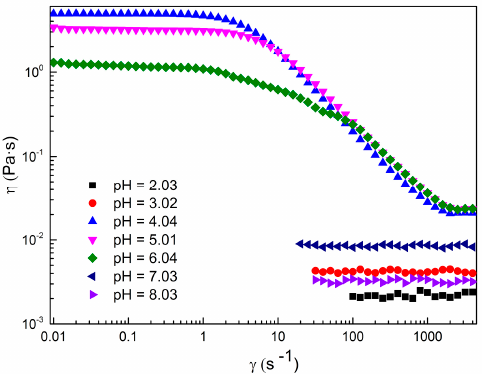
Figure 1. Steady shear viscosity versus shear rate γ (with a dot over the symbol) plots for 80 mM C 16 MPBr-AA aqueous solutions with different pH values.